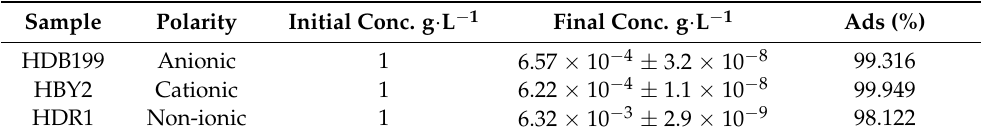
Table 1. Difference in concentration after HC